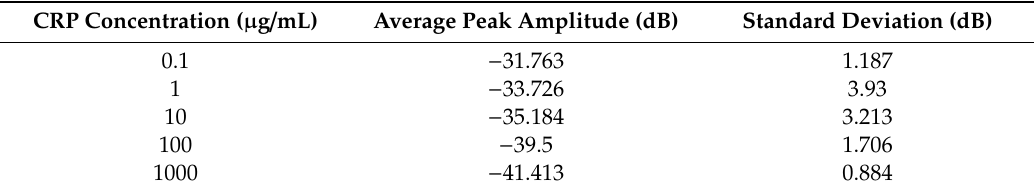
Table 1. The averaged values of the peak amplitude and the related standard deviations with di ff erent CRP